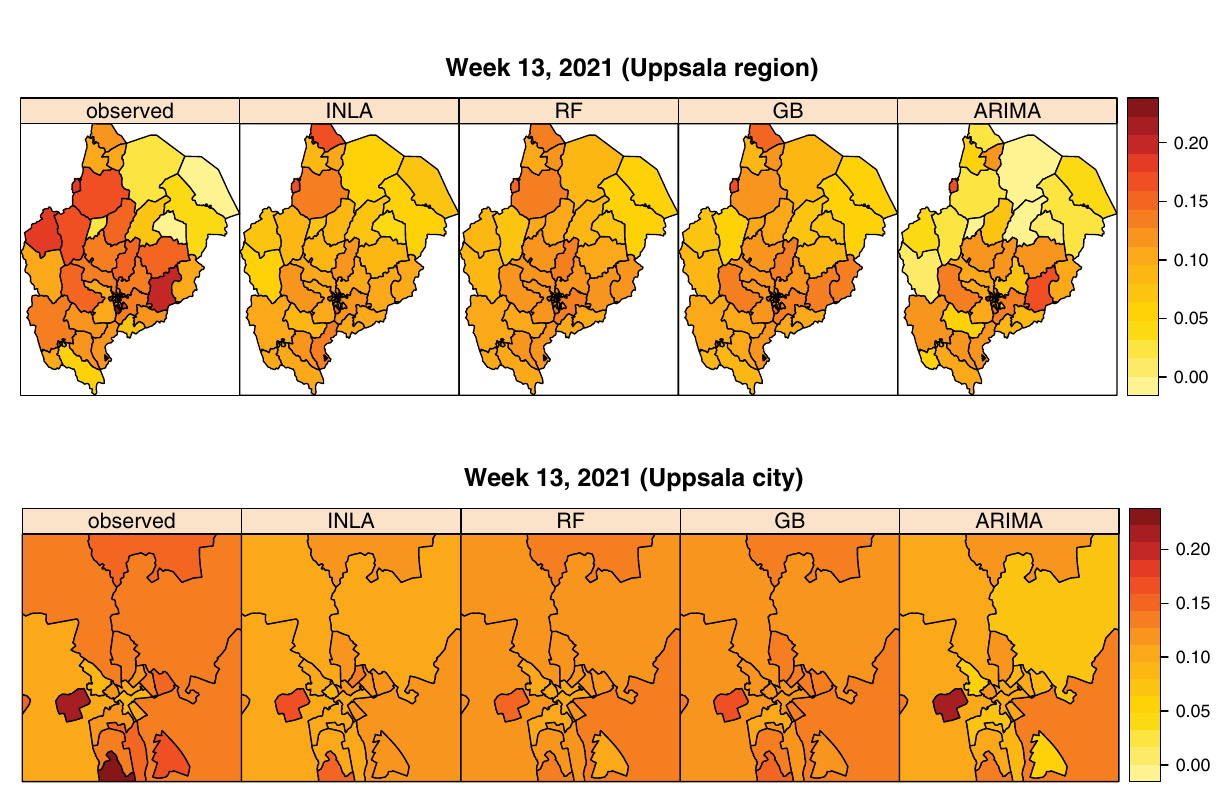
Figure 7. Maps of observed and predicted test positivity in week 13, 2021, at the peak of the third wave of the pandemic. Uppsala county (top) and zoom-in of Uppsala city